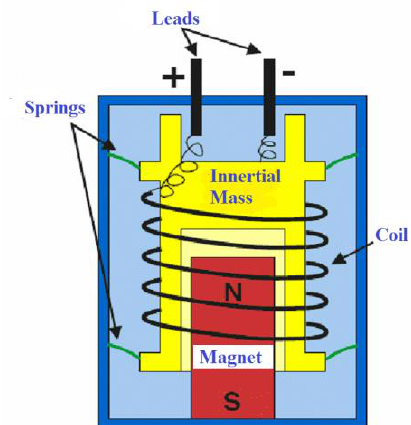
Figure 4. Schematic drawing of a tunnel threat-detecting sensor.